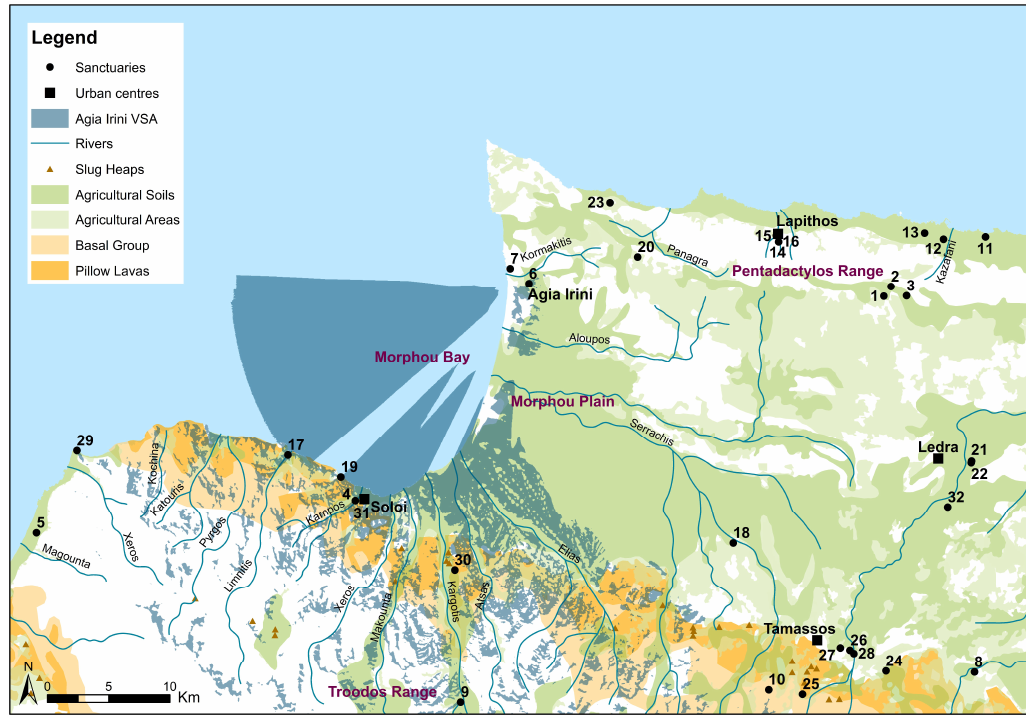
Figure 8. Visibility Analysis from Agia Irini; Digital data courtesy of the Geological Survey Department, Cyprus (by Charalambos Paraskeva).